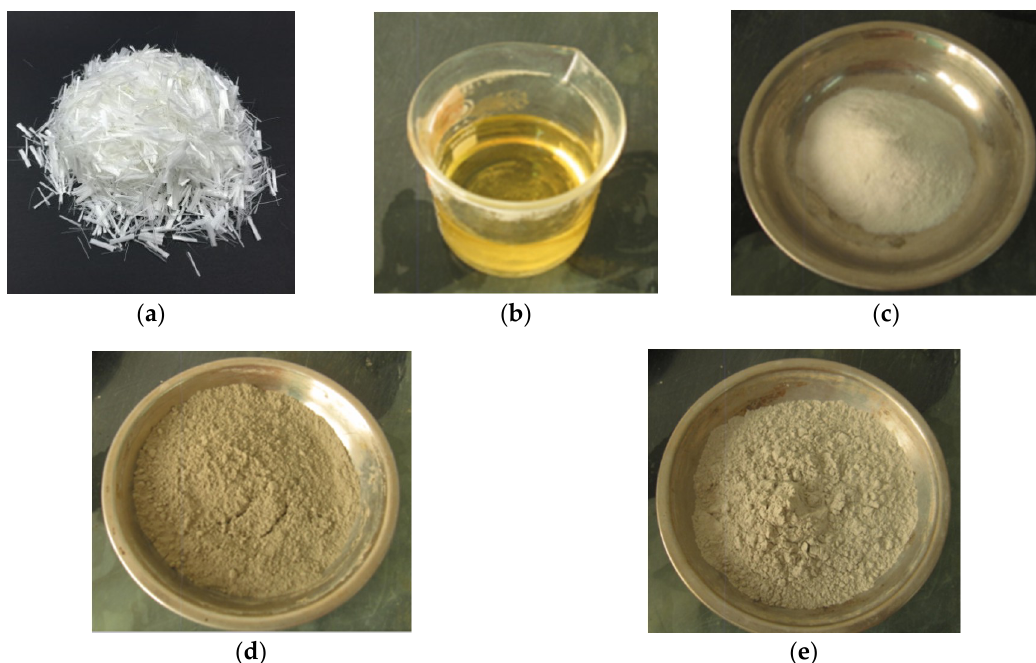
Figure 4. Raw materials used in the preparation of the HVFA-SHCC samples. ( a ) polyvinyl alcohol (PVA) fiber; ( b ) superplasticizer (SP); ( c ) silica sand; ( d ) fly ash; ( e ) cement. Table 3. Chemical compositions of cement and fly ash (major constituents).